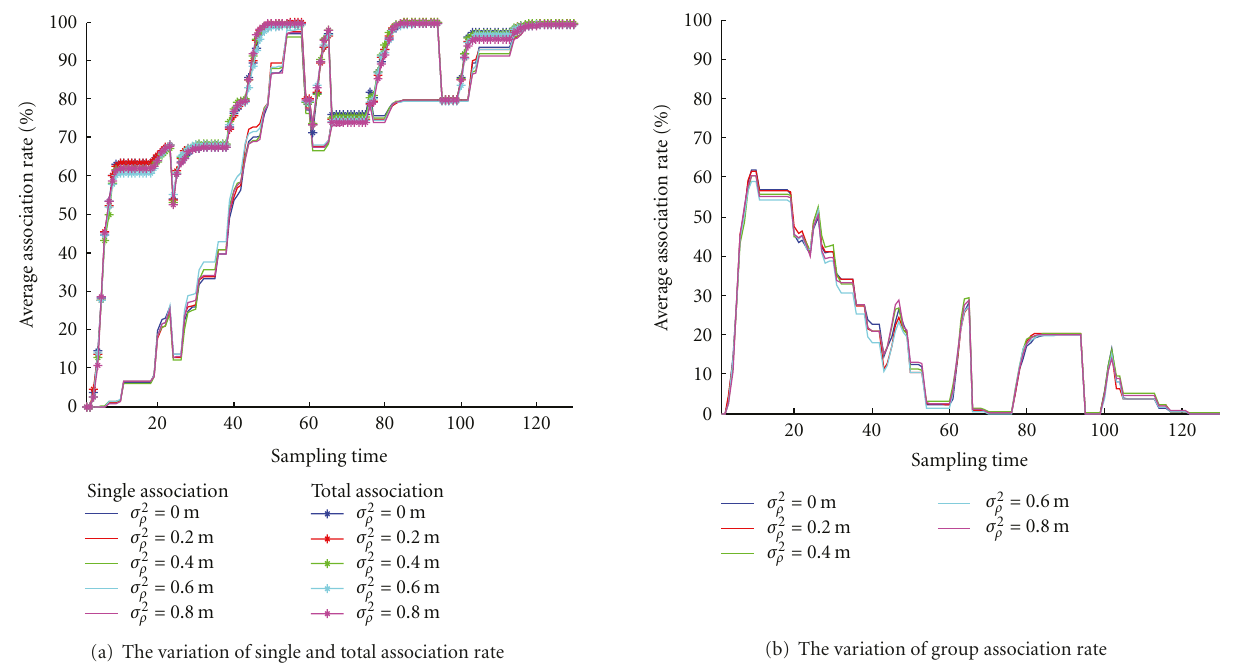
Figure 14: The simulation of the association performance according to the variation of the modeled